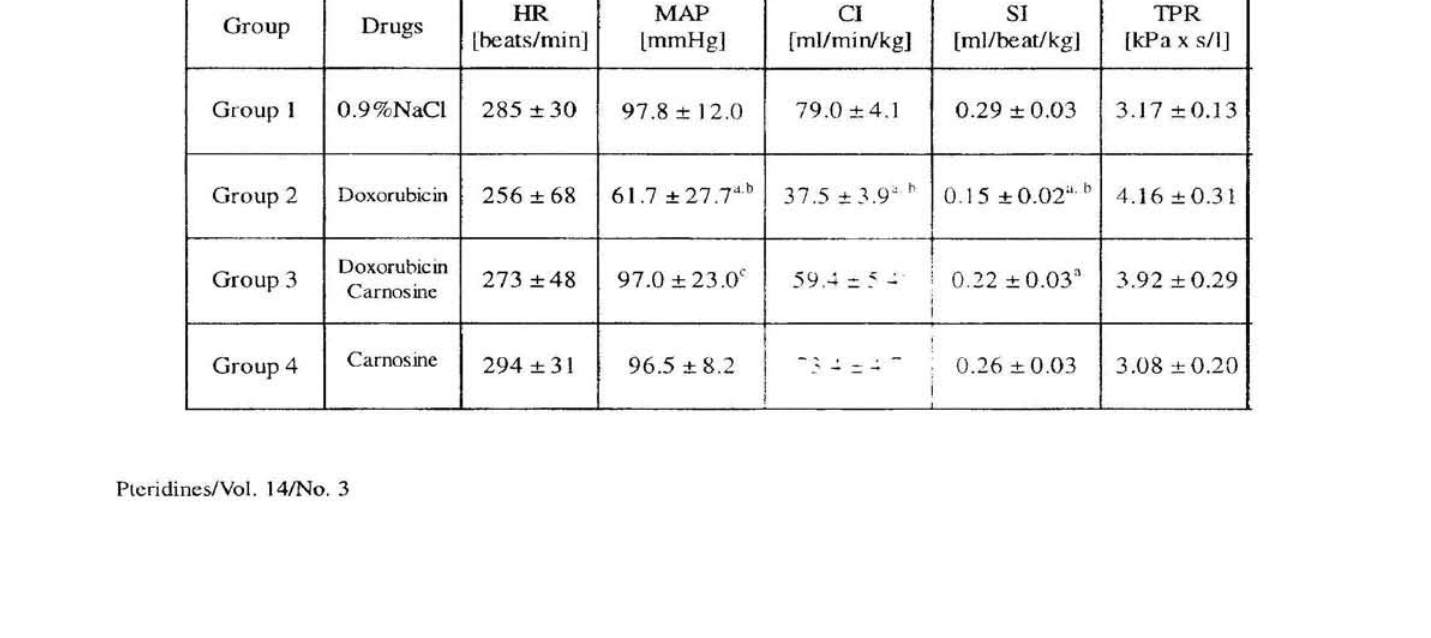
Table 2. Heart rate (HR), mean arterial pressure (MAP), cardiac index (Ci), stroke index (SI) and total peripli eral vascular resistance (TPR) in the 4 groups of rabbits Mean values ± S.D. are shown, HR heart rate, MAP mean arterial pressure, CI cardiac index, SI stroke index, TPR total peripheral